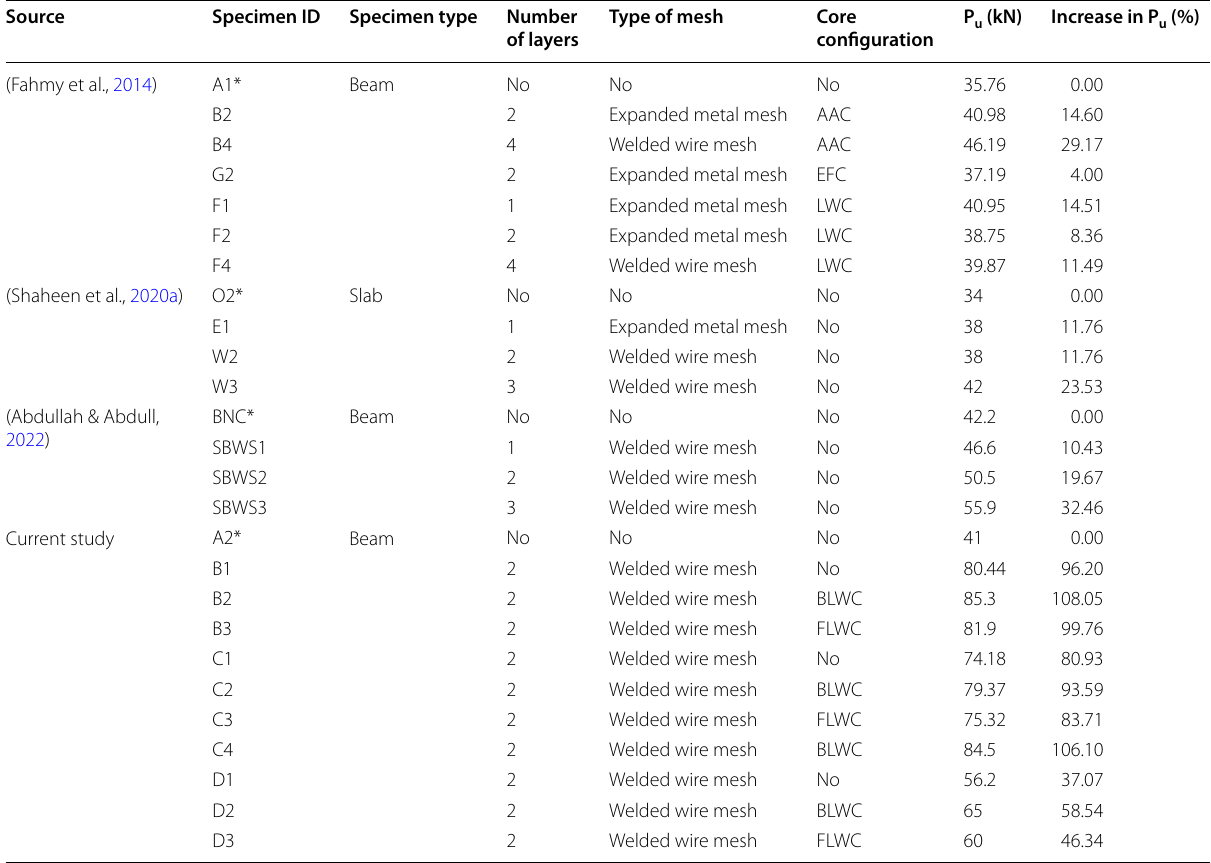
AAC is Autoclaved Aerated lightweight brick Core, EFC is Extruded Foam Core, and LWC is Lightweight Concrete Core * is control normal-weight concrete